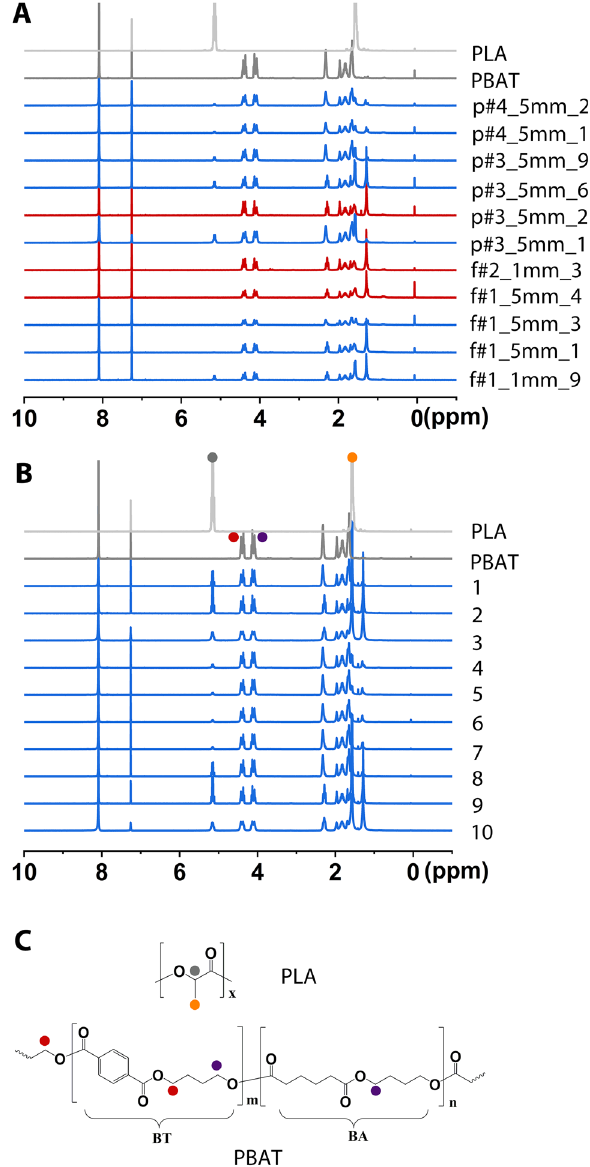
Figure 3. 1 H NMR spectra of BDP fragments from composts and commercial bags. ( A ) BDP fragments recovered from the composts and ( B ) the commercial compostable bags. Fragments were coded as follows: p or f for pre-compost or finished compost, followed by the plant number (#1 to #4), an indication of the size fraction (> 5 mm or 1–5 mm) in which the fragment was found, and finally, the fragment number. Bags were arbitrarily numbered 1–10, see Suppl Table S1 for supplier information. The spectra (in grey) of the reference materials for PLA and PBAT are given as basis for the interpretation. Spectra in red refer to test samples consisting only of PBAT, while those in blue indicate samples composed of PBAT/PLA mixtures. ( C ) Chemical structures of PLA and PBAT, chemical shifts of the protons are assigned as indicated in the reference spectra in ( B